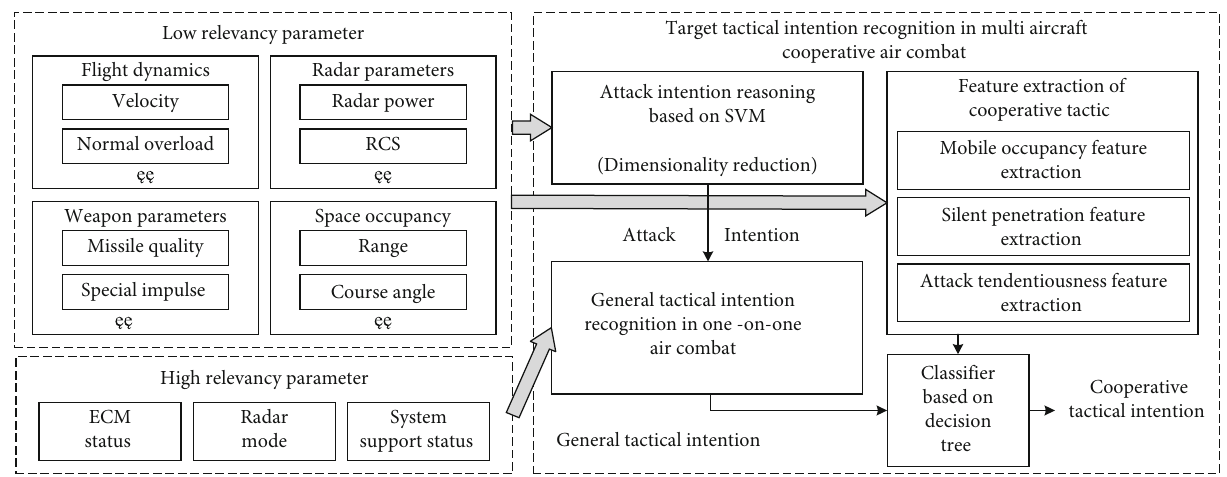
Figure 2: The general technical scheme block diagram for target tactical intention recognition in multiaircraft cooperative air combat.